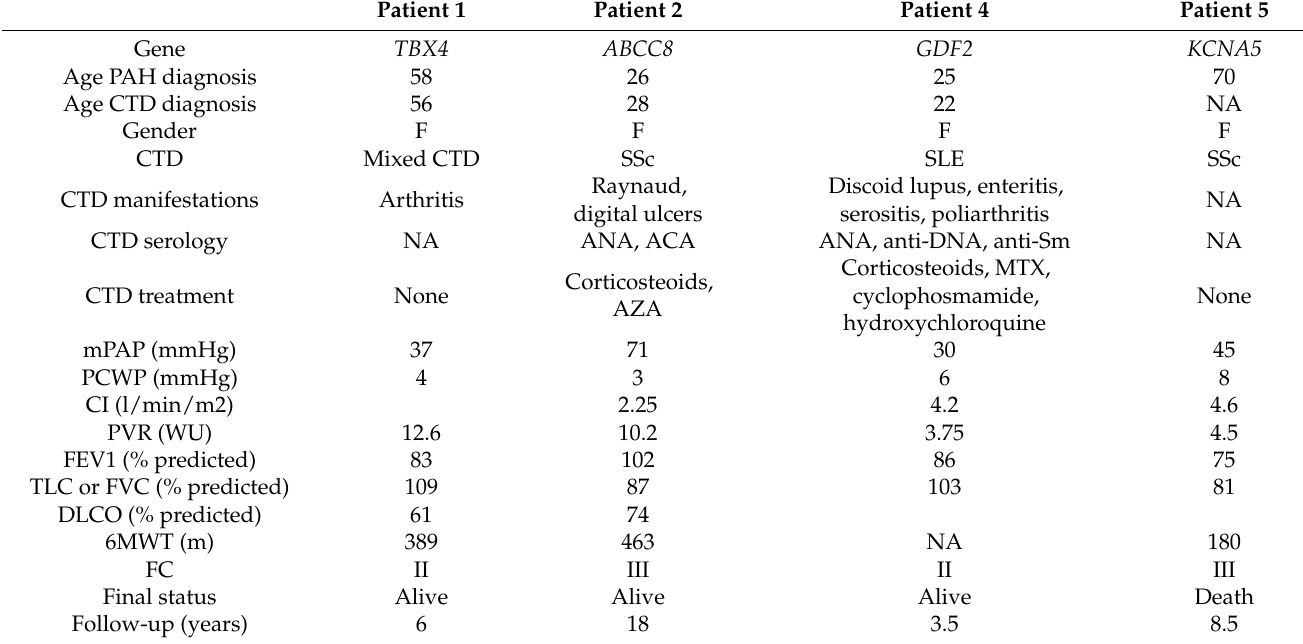
Table 2. Clinical characteristics of patients with pathogenic or likely pathogenic